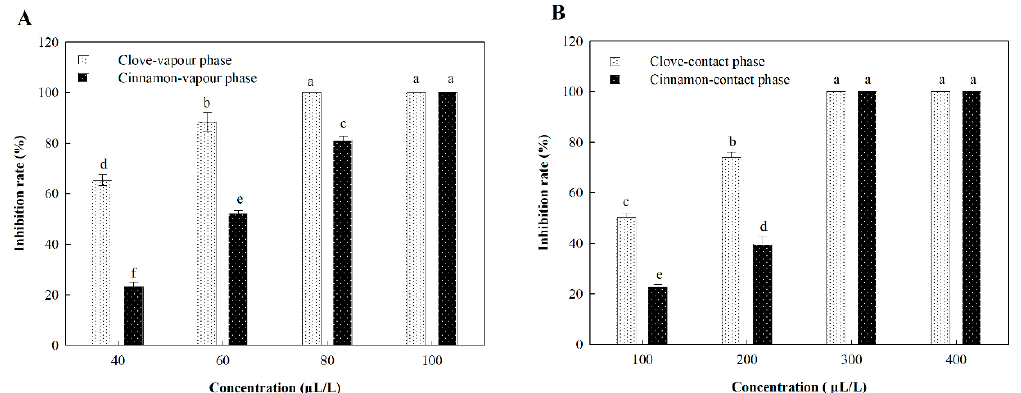
Figure 3. The inhibition activity of cinnamon and clove oil against C. gloeosporioides by ( A ) fumigation